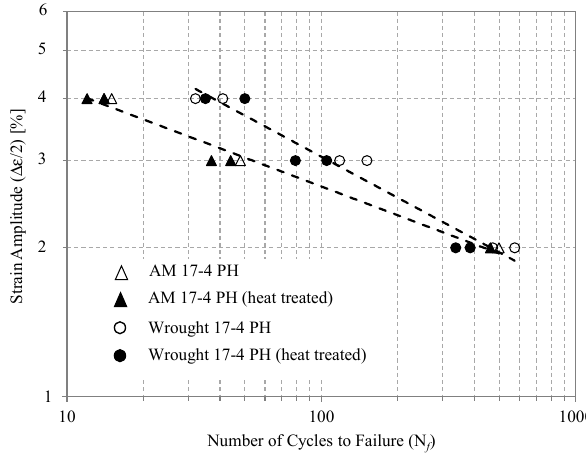
Figure 6. Fully reversed (R = − 1) strain-life fatigue curves for 17-PH AM-AB, AM-HT, W-AR, and W-HT steels.